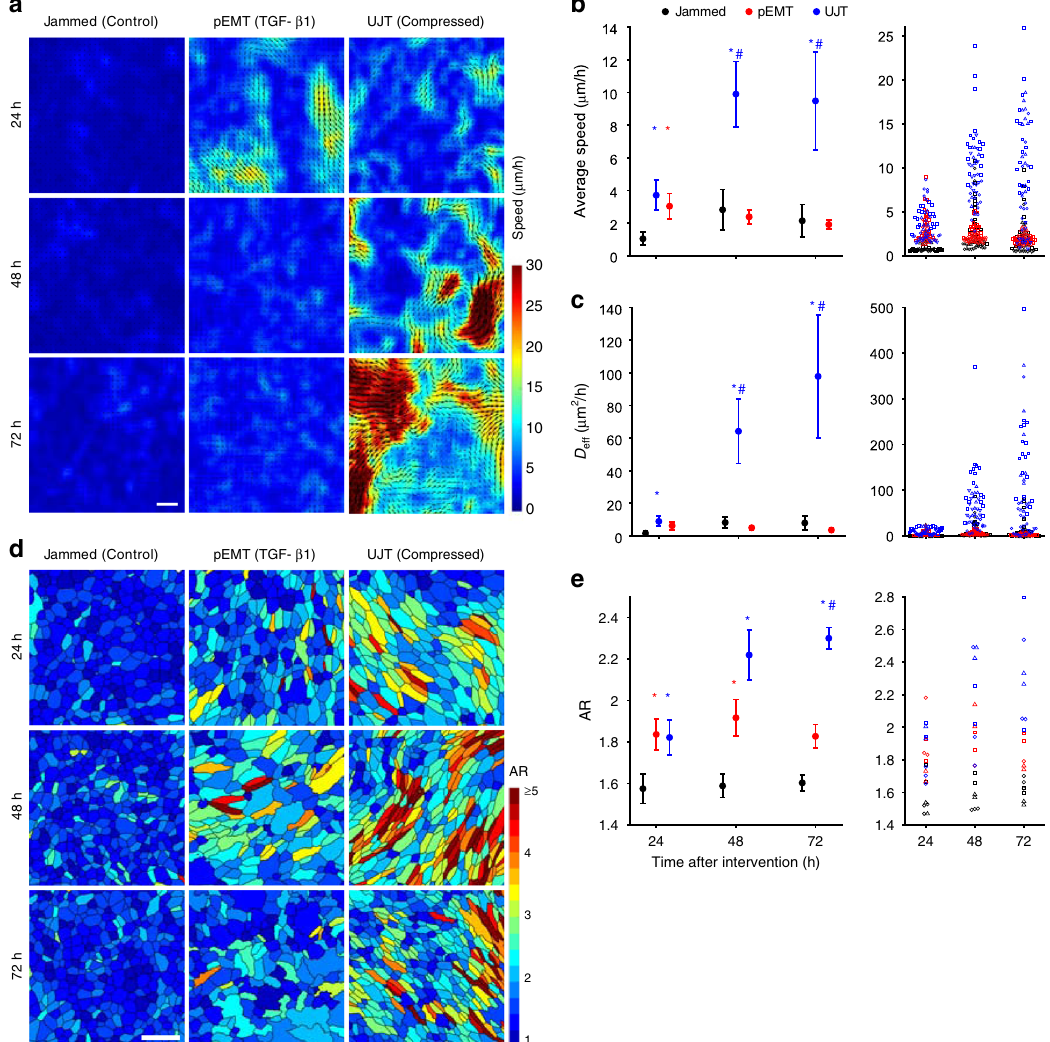
Fig. 1 In both dynamics and structure, pEMT and UJT diverge over time. In well-differentiated HBE cells, pEMT was induced by TGF- β 1 (10 ng/ml) and UJT was induced by compression 37,66,84,89 . Representative speed maps (obtained using optical fl ow, see “ Methods ” section; Scale bar in a is 100 µ m) a , average speed b , and effective diffusivity c for jammed, pEMT and UJT at 24, 48, and 72 h. b , c Left panel: mean ± SEM for n = 4 donors; right panel: measurements for each fi eld of view across donors, with symbol shape denoting each donor. Jammed cells remain essentially stationary over all times. Cells undergoing pEMT migrate moderately at 24 h but return to baseline by 48 h. Cells undergoing UJT display progressively increasing migratory speed and diffusivity over time. Individual cells color-coded by aspect ratio (AR) d and quanti fi ed by mean AR ( e ) for jammed, pEMT, and UJT at 24, 48, and 72 h. Scale bar in d is 50 µ m. e Left panel: mean ± SEM for n = 3 donors; right panel: measurements for each fi eld of view across donors, with shape denoting each donor. Elevated cellular AR represents a structural signature of the unjamming transition 37,39 . * p < 0.05, vs. control; # p < 0.05, UJT vs. pEMT, color- coded according to which sample is referenced, one-way ANOVA followed by post-hoc multiple comparisons with Bonferroni correction. Mean (SEM) and full datasets available in Supplementary Table 1 and online Source Data fi le,